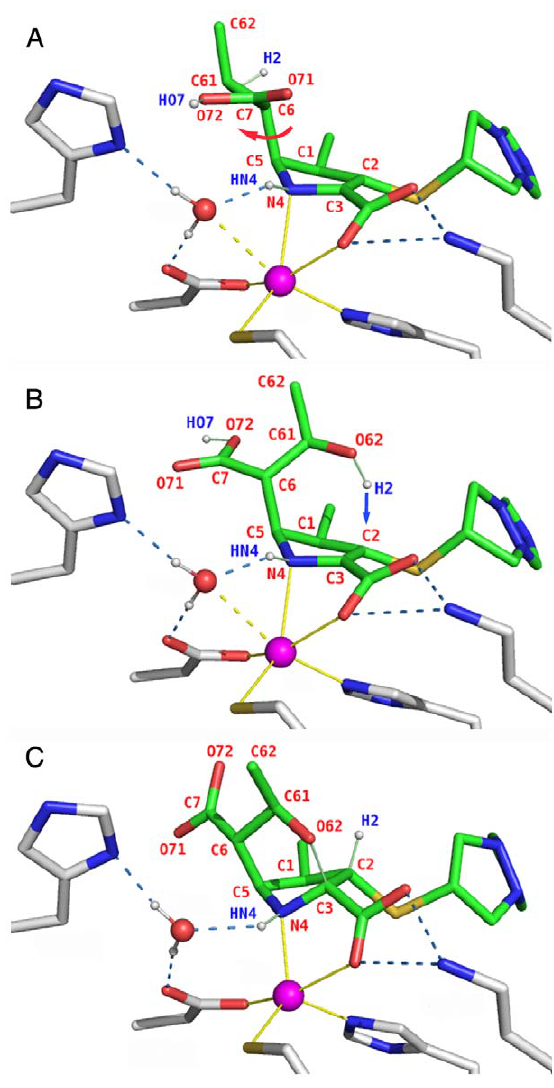
Figure 2. Formation of the bicyclic derivative of biapenem. A. QM/MM optimized model of the active site of CphA in complex with hydrolyzed biapenem (‘‘Conformation A’’ in the metadynamics analysis of the hydroxyethyl group rotations described later on). In the configuration shown here both N4 and the C6 carboxylate are protonated (atoms HN4 and HO7). A water molecule (originating from bulk solvent after the hydrolysis reaction is completed) is hydrogen bonded to Asp120 and loosely coordinated to Zn 2 + (dashed yellow bond). Zn 2 + has only five strong ligands, in agreement with spectroscopic data [29]. A red arrow indicates the rotation of the C6 carboxylate and hydroxyethyl moieties (the latter only partially visible) required to generate the open-ring form shown in the next panel. B. Conformation of hydrolyzed biapenem that precedes the formation of the bicyclic compound (‘‘Conformation B’’ in the metadynamics analysis of the hydroxyethyl group rotations). A blue arrow indicates the proton transfer from O62 to C2 required to generate the bicyclic compound. C. Active site of CphA in complex with the bicyclic derivative of biapenem. The C2–H2 and O62–C3 bonds formed during the rearrangement are shown as thin green lines. N4 is protonated.